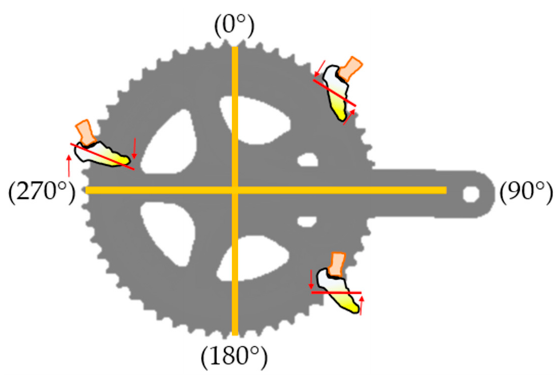
Figure 4. Power application phases and foot angle correction on the pedal while pedaling.